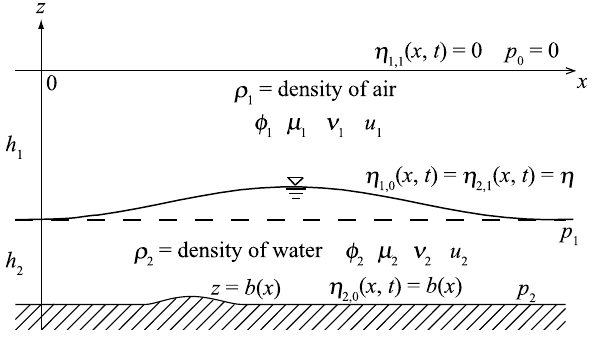
Figure 5. A two-layer fluid for water